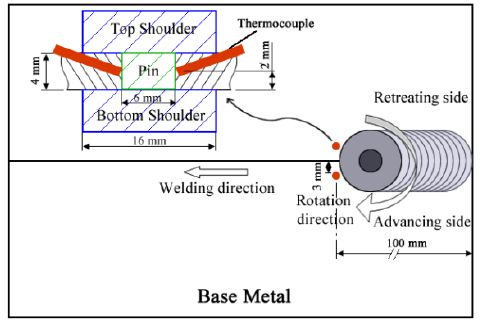
Figure 2. Schematic illustration of the test method for the thermal cycle curve.